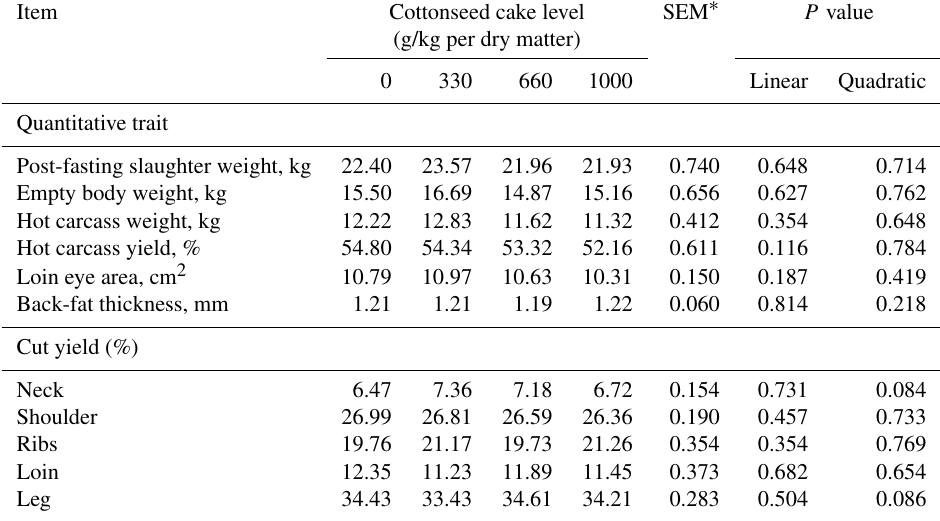
Table 3. Quantitative traits and yields of primal cuts from the carcass of feedlot goats fed diets containing cottonseed cake replacing soybean meal.